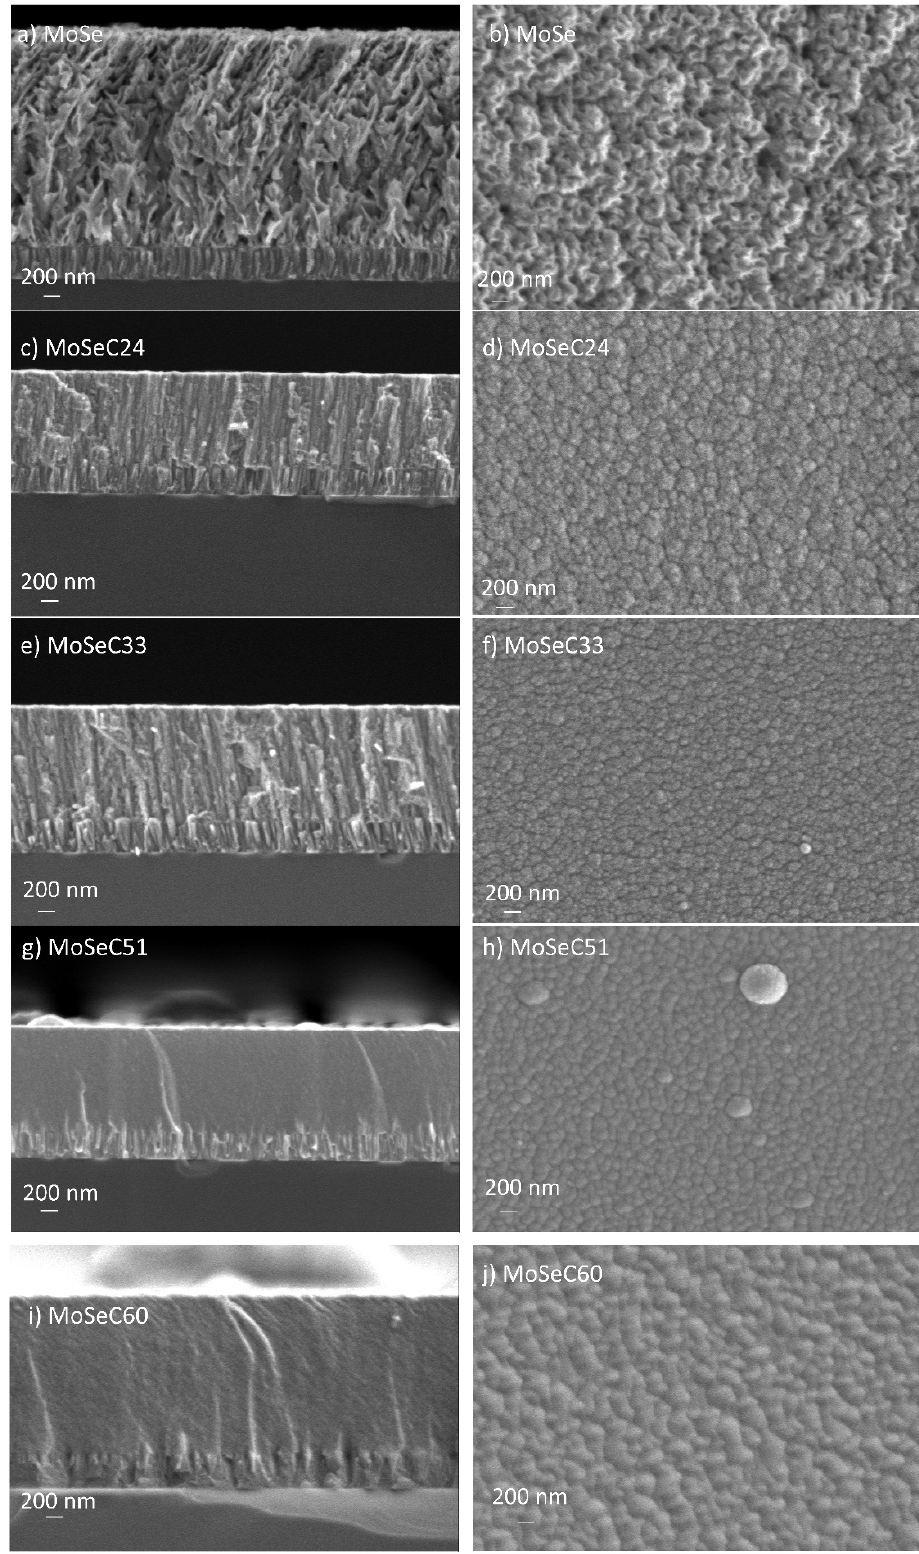
Figure 3. Cross section (CS) and surface morphology (SM) of the Mo-Se-C coatings obtained via